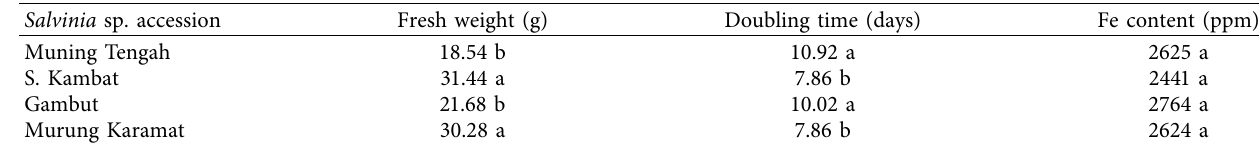
Table 8: The fresh weight of Salvinia sp. biomass, the doubling time of Salvinia sp. plant, and the Fe content in Salvinia sp. tissue after 4weeks of maintenance in soil growing medium that originated from tidal swampland. Salvinia sp. accession